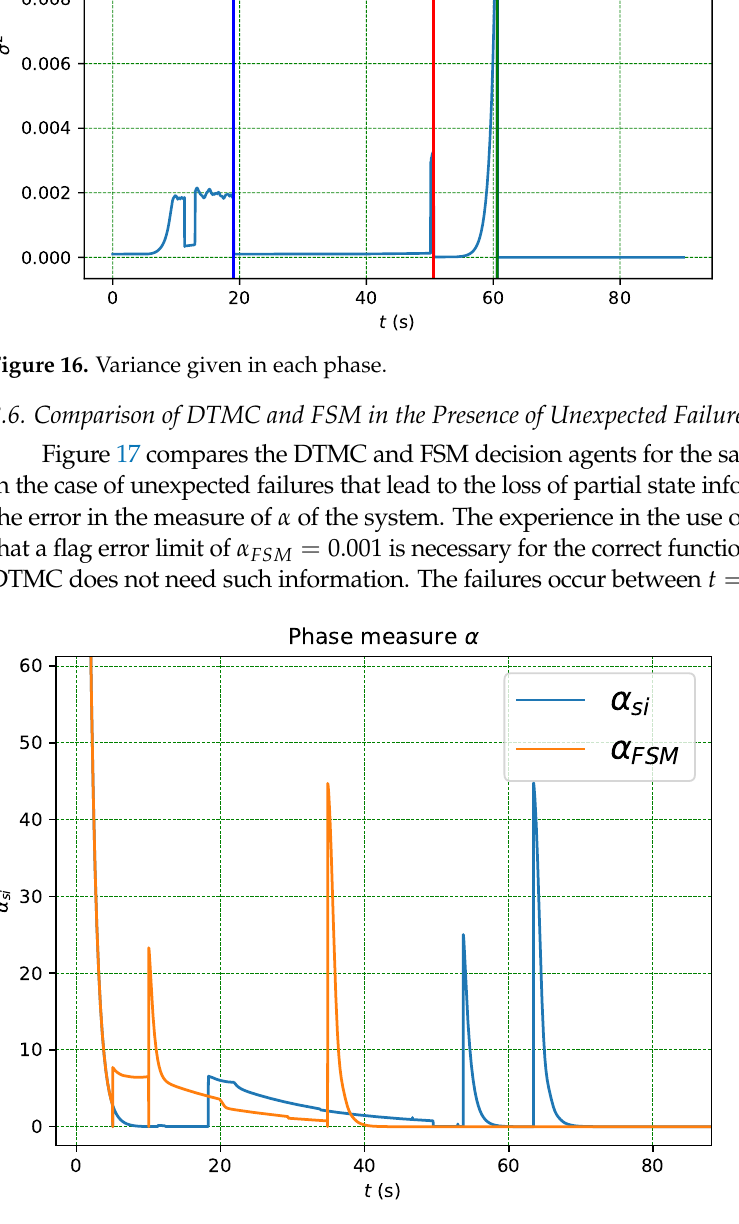
Figure 17. Comparison between DTMC and FSM decision